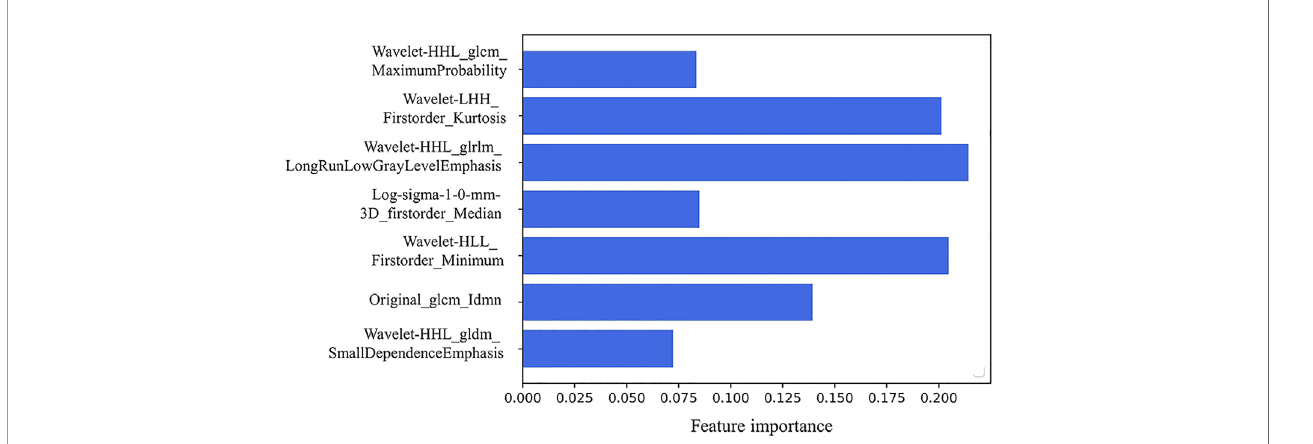
FIGURE 5 | The seven selected radiomic features to establish the radiomic-based model: three wavelet-based texture features, two wavelet-based fi rst-order features, one LoG-based fi rst-order feature, and one original texture feature. Feature importance of the selected radiomics features. The importance coef fi cient in the x -axis was computed according to each feature ’ s average importance value in a single tree of the GBDT